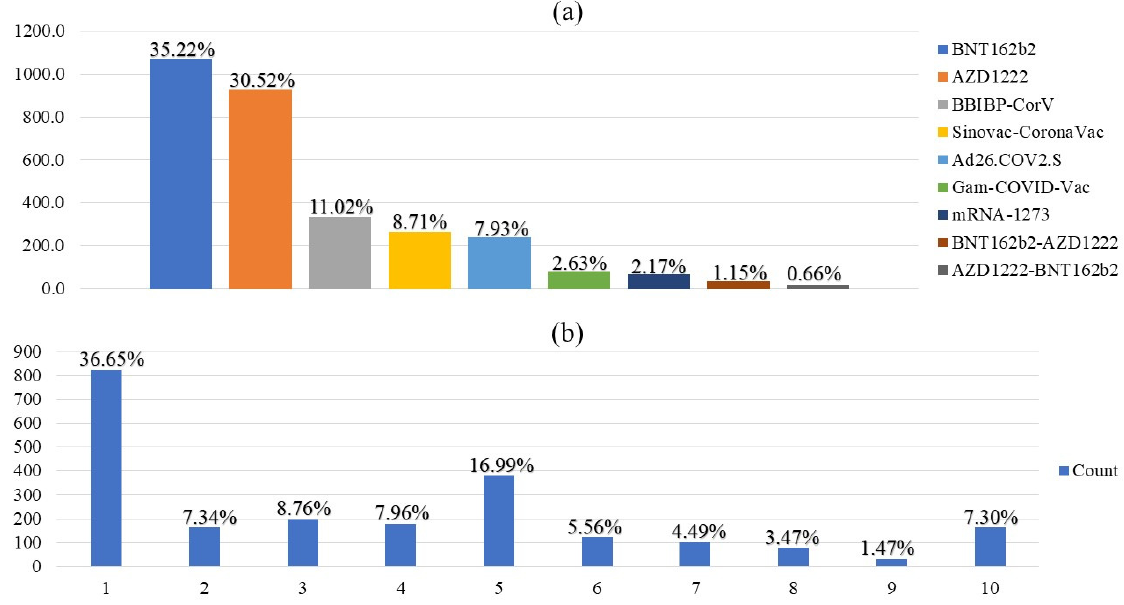
Figure 2. ( a ) Frequency and percentage of COVID-19 vaccination ( n = 3041); ( b ) Fear count and percentage on a 10-point Likert scale ( n = 2248; 10 is the highest fear score).